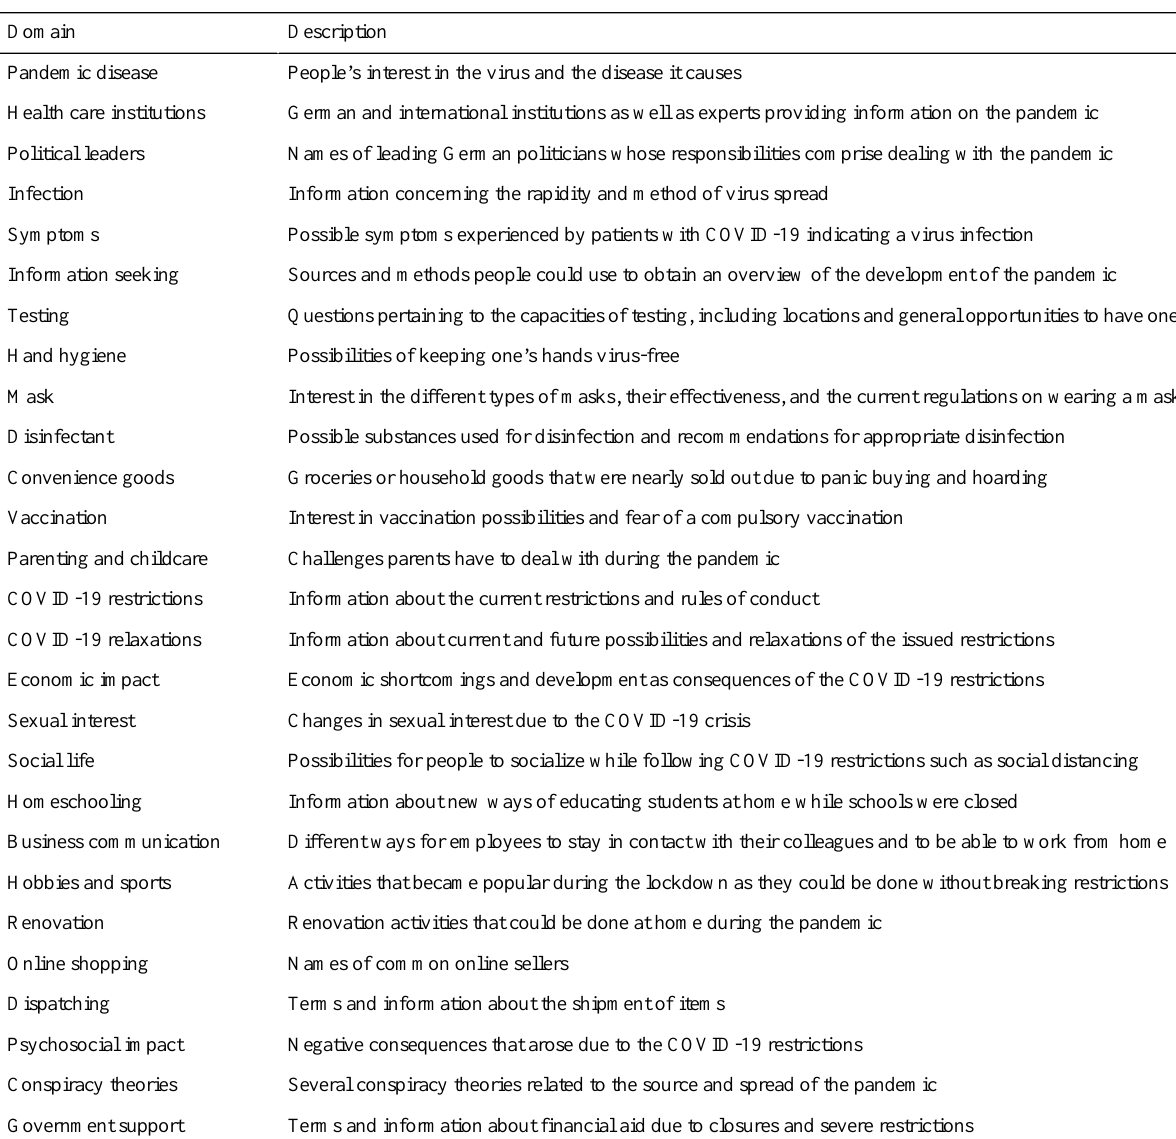
Table 1. All 27 domains and their relevant